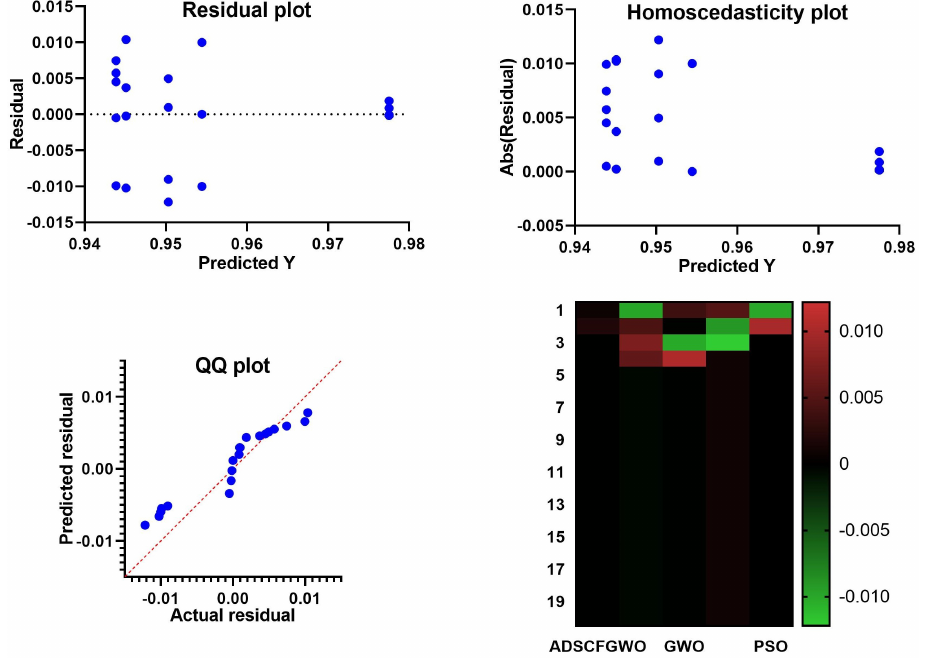
Figure 6. Residual, homoscedasticity, and QQ plots and heatmap of the ADSCFGWO and compared